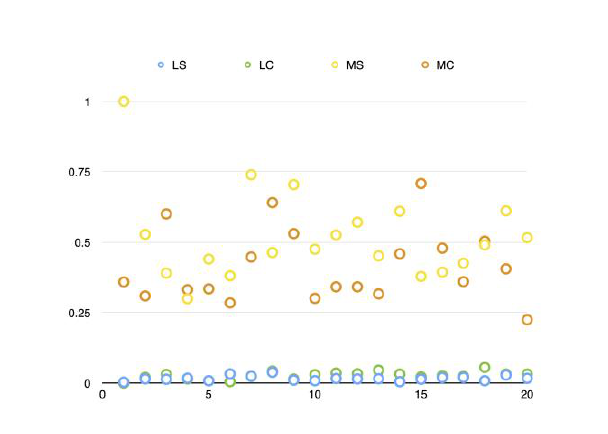
Figure 3: Plot showing normalised variance in acceleration (m.s -2 ) along y-axis for Legato and Martelé segments.